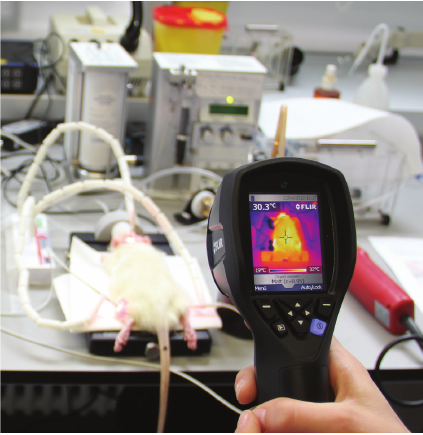
Figure 3: Temperature measurements using a Flir i7 infrared thermocamera.